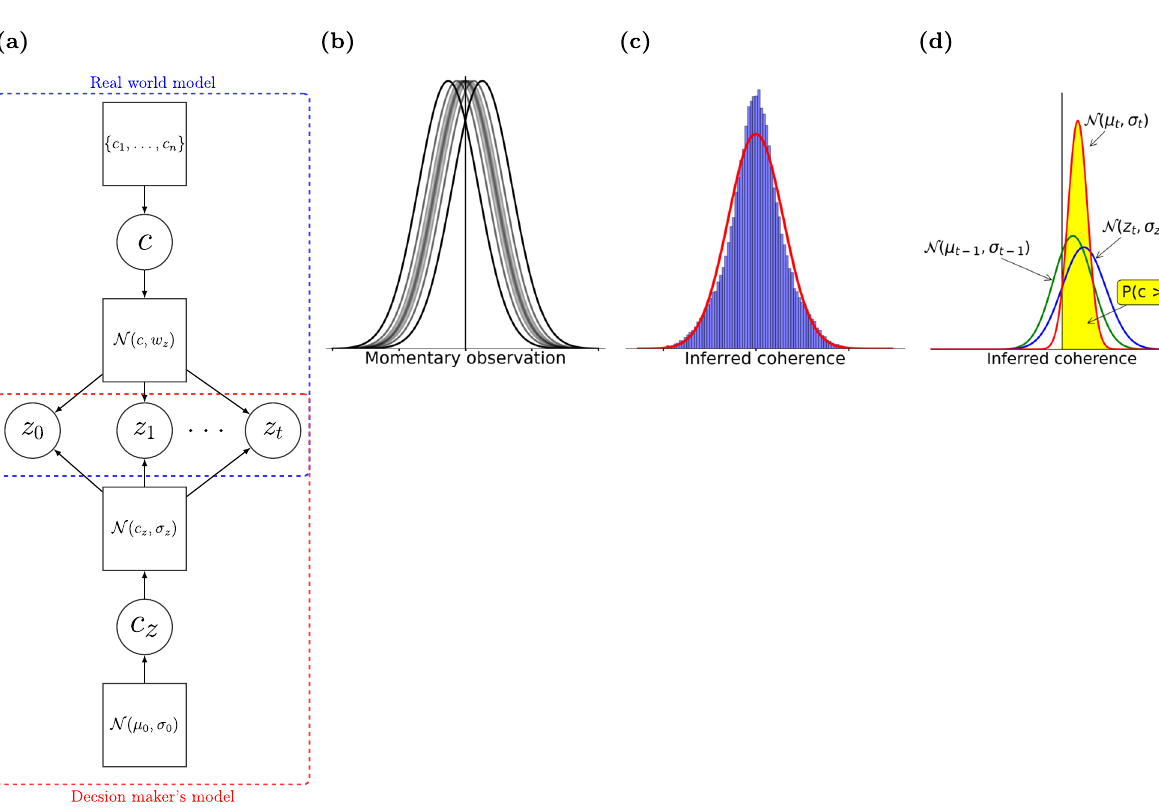
NATURE COMMUNICATIONS| (2021) 12:5704